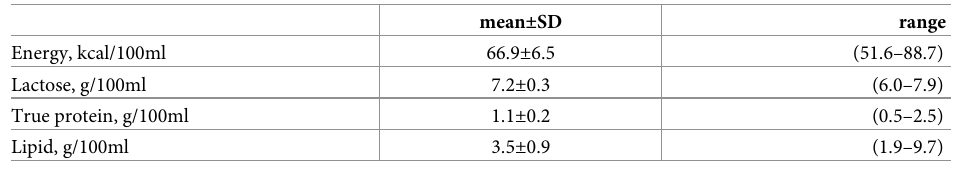
Table 2. Macronutrient concentration in human milk samples (N =